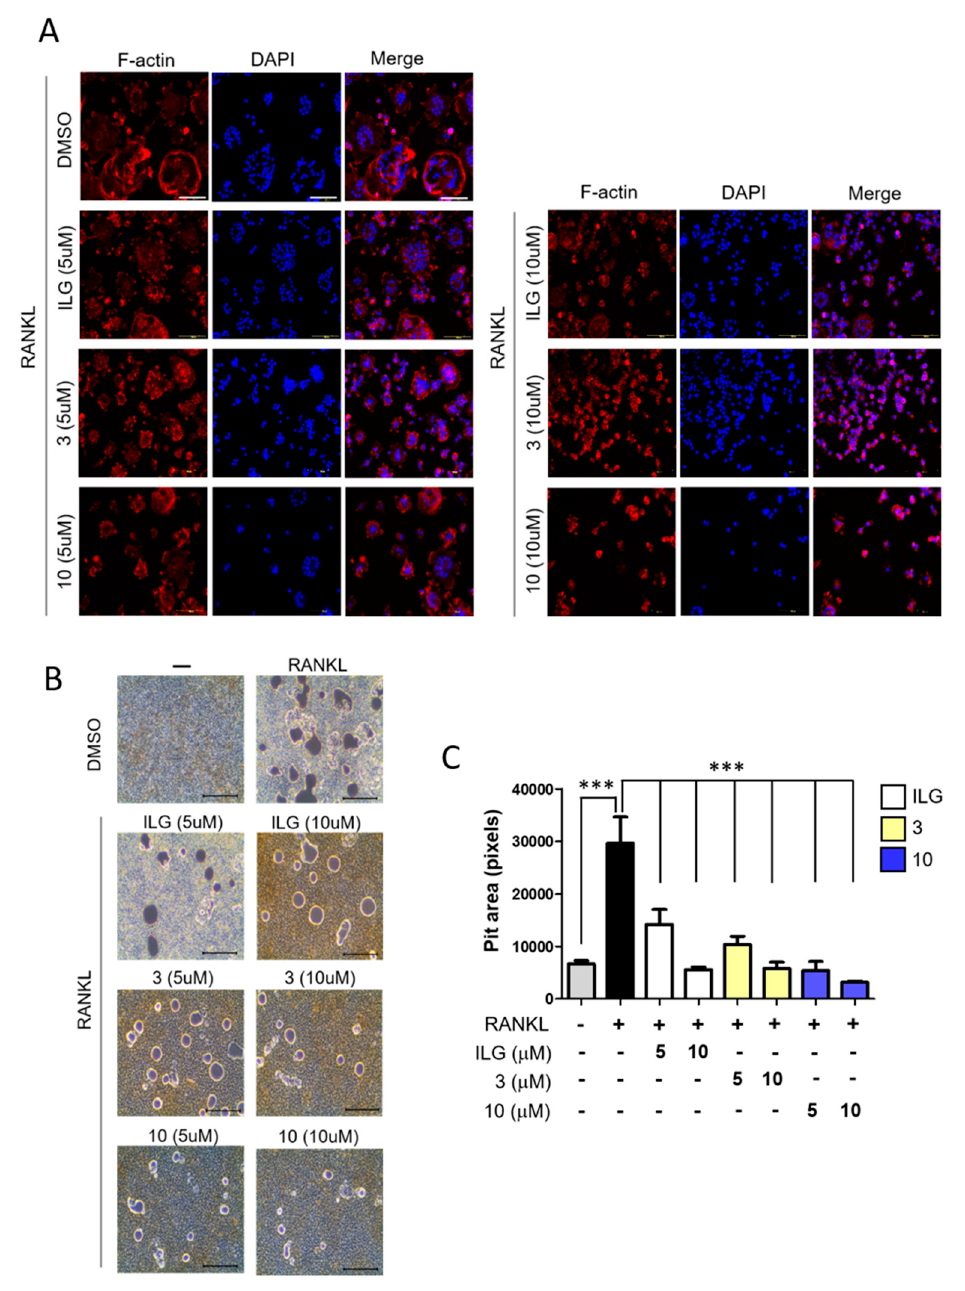
Figure 5. ILG and ILG derivatives suppress RANKL-induced bone resorption and actin ring formation. ( A ) Raw264.7 cells were stimulated with RANKL (40 ng / mL) in presence of ILG or ILG derivatives (5 and 10 µ M) for 4 days. Cells were fixed and stained with phalloidin and DAPI to determine actin ring formation of osteoclast. Scale bar = 100 µ m. ( B , C ) RAW264.7 cells were seeded on CaP-coated plate and stimulated with RANKL (100 ng / mL) to induce di ff erentiation to osteoclast. The presence of ILG or ILG derivatives (5 and 10 µ M) were treated in osteoclast and stimulated with RANKL (100 ng / mL) for 6 days. ( B ) Resorption pit areas were visualized by a light microscopy (100 × ). Scale bar = 400 µ m. ( C ) Resorption pit areas were measured. *** p < 0.001 ( n ≥ 3).